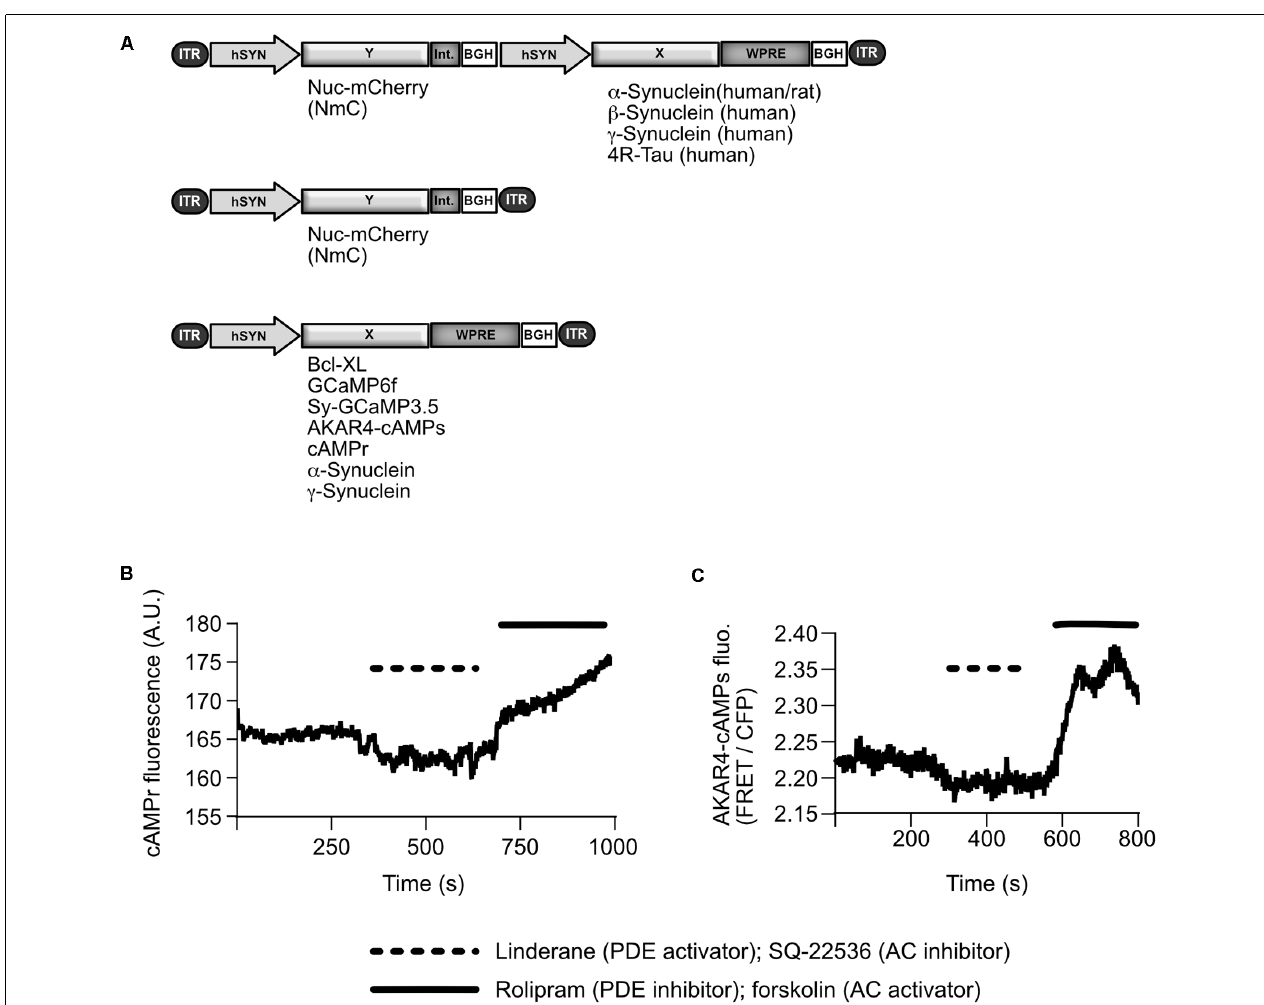
FIGURE 1 | AAV vectors as used in this study and characteristics of cAMP sensors. (A) Schematical depiction of AAV vector genomes: for most experiments the synucleins ( α -Syn, β -Syn, or γ -Syn) were expressed from bi-cistronic vectors, which also express the fluorophore nuclear-targeted mCherry (Nuc-mCherry, NmC) from an independent transcription unit. As an additional control, or “empty vector”, NmC was expressed alone from a mono-cistronic vector. Bcl-xL, genetically encoded fluorescent sensors, and synucleins were expressed from mono-cistronic vectors in specific conditions. ITR, inverted terminal repeat of AAV2; hSyn, human synapsin 1 gene promoter; Int., Intron (splice sites); BGH, bovine growth hormone polyadenylation site; WPRE, woodchuck hepatitis virus posttranscriptional regulatory element. (B) Representative trace of cAMPr absolute fluorescence changes in one neuron, which was treated with compounds that alter cAMP level. The trace has been corrected for bleaching. Dashed line = time duration for applying linderane, 20 mM, and SQ-22536 = 20 µ M; straight line = time duration for applying rolipram, 5 µ M, and forskolin, 5 µ M). A.U., arbitrary units; PDE, phosphodiesterase; AC, adenylate cyclase. (C) Representative trace of AKAR4-cAMPs FRET ratio changes in one neuron after reducing cAMP levels with linderane/SQ-22536 or enhancing cAMP levels with forskolin/rolipram.